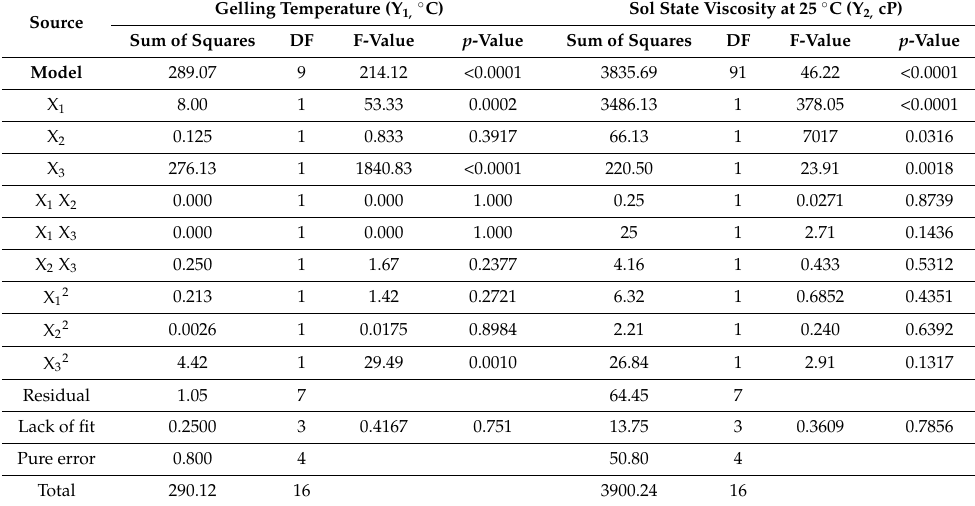
Table 3. Results obtained from ANOVA of BBD for optimization of gelling temperature and solution state viscosity of NEB-loaded dual-responsive in situ